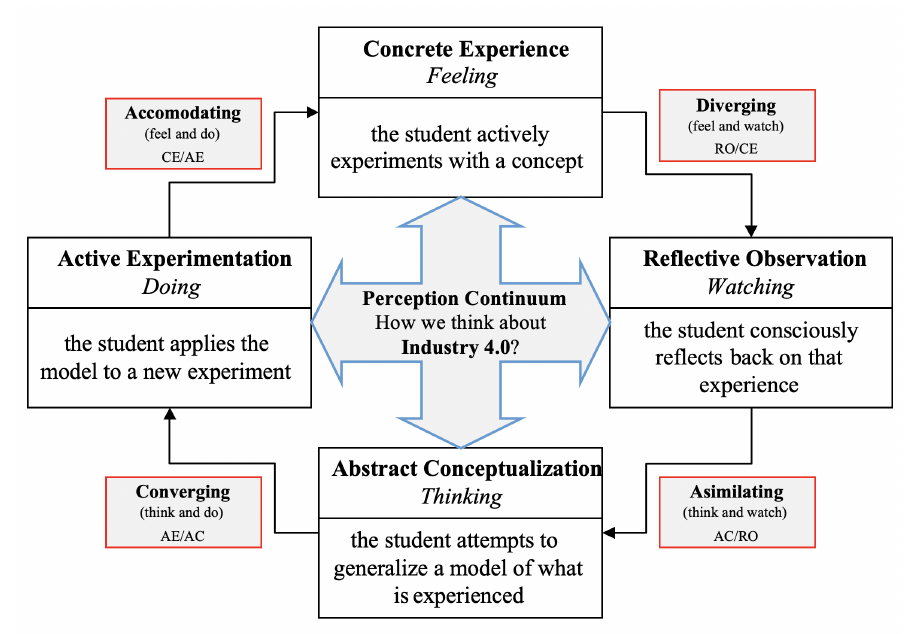
Figure 2. Kolb’s learning styles model and experiential learning